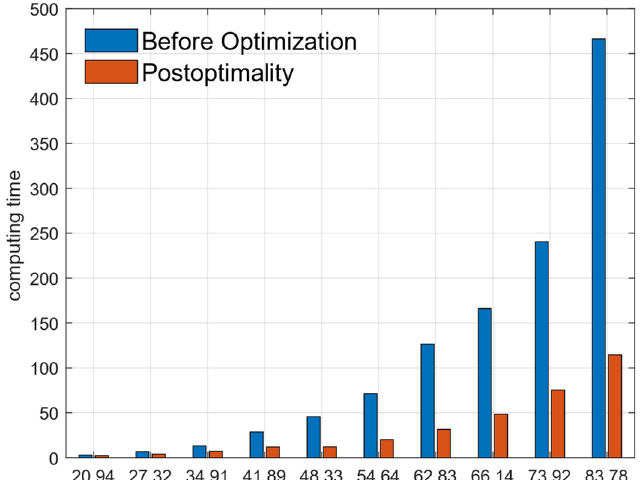
Figure 13. Comparison of calculation efficiency before and after improving, the abscissa is the size parameter, and the ordinate is the calculation time.